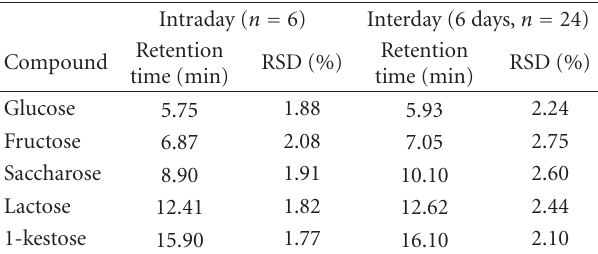
Table 5: Reproducibility of retention times for intra- and interday analyses for the symbiotic milk sample by HPAEC-PED (separation conditions as in Figure 5).